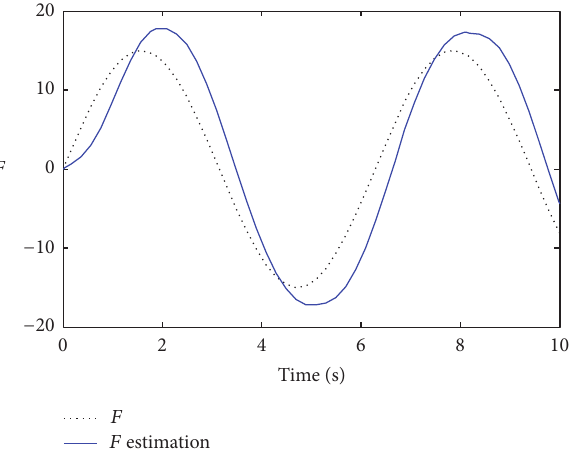
Figure 12: Adaptive tracking trajectory of 𝐹